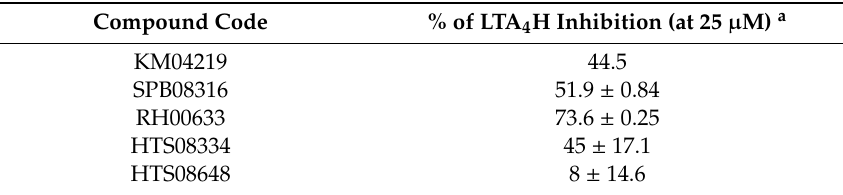
Table 3. Inhibitory activity of the selected hits.